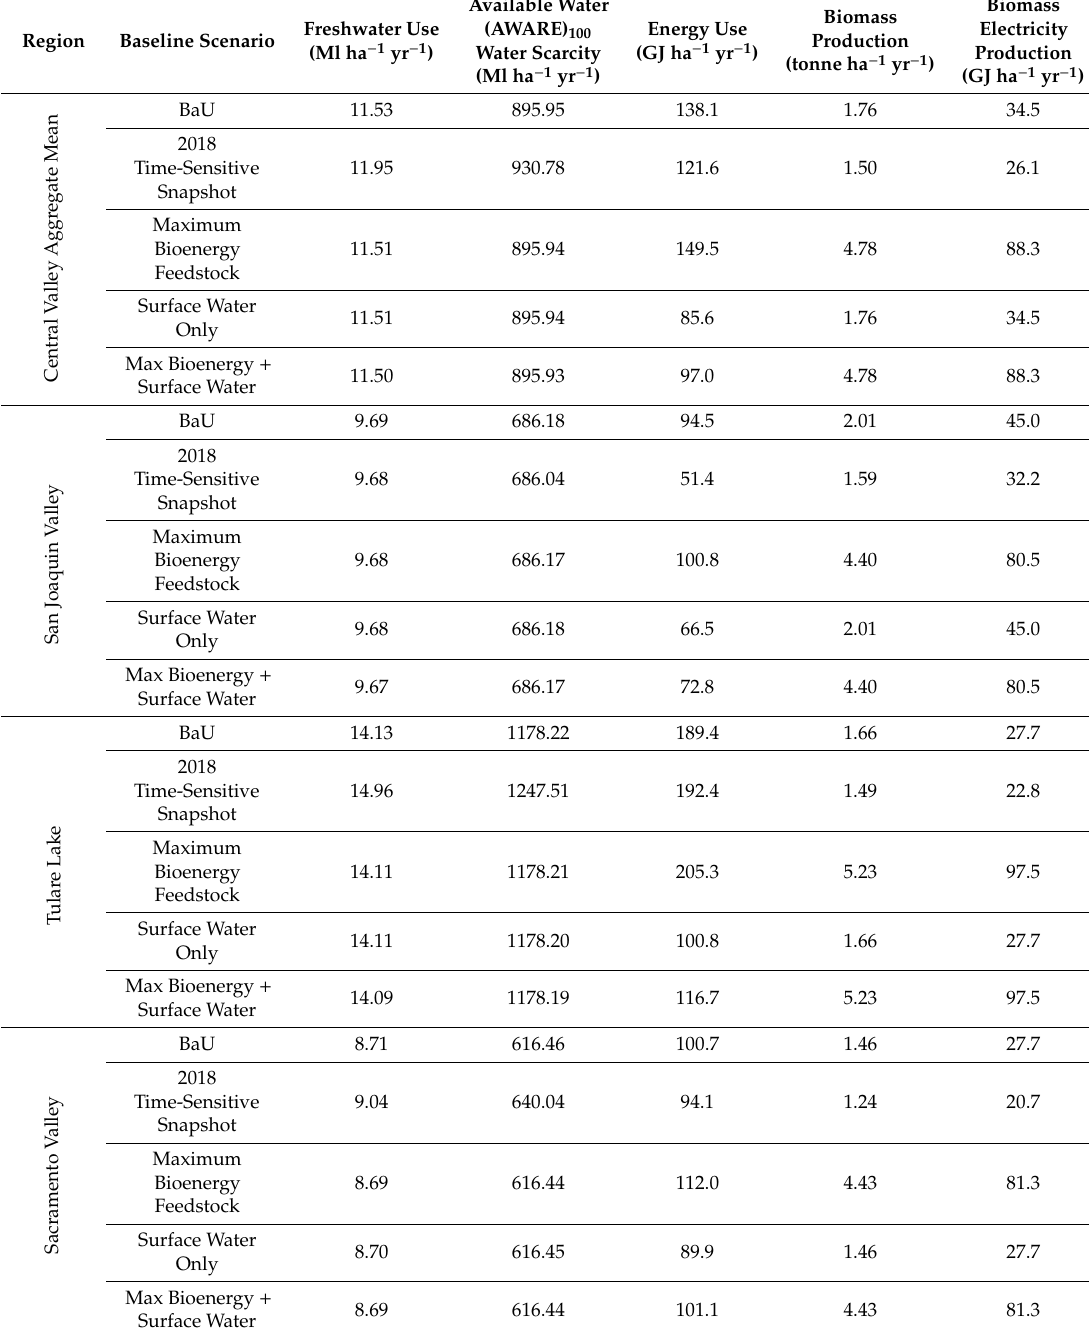
Table 2. Regional scenario baseline